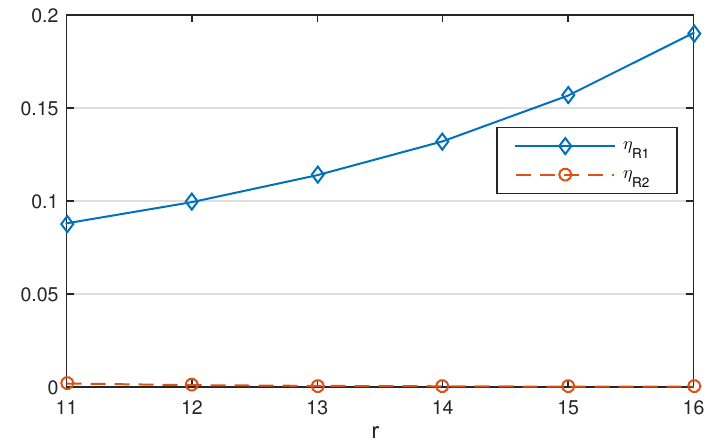
Figure 4. Mean reorder rate for two suppliers vs. r